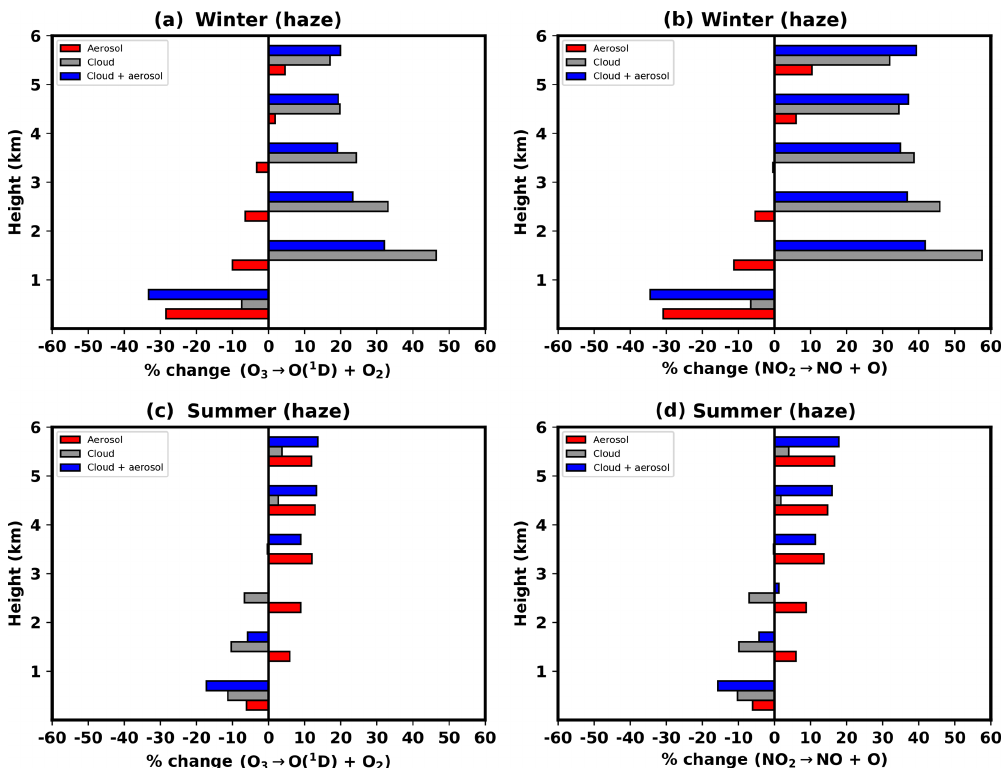
Figure 5. Mean relative impacts of aerosols (red bars), clouds (grey bars), and combined cloud and aerosol (blue bars) on J [O 1 D] ( a, c ) and J [NO 2 ] ( b, d ) during the winter ( a, b ) and summer ( c, d ) campaign periods. The relative differences are with respect to clear-sky conditions and are calculated as the average for periods classified as haze in 1km layers from the surface to